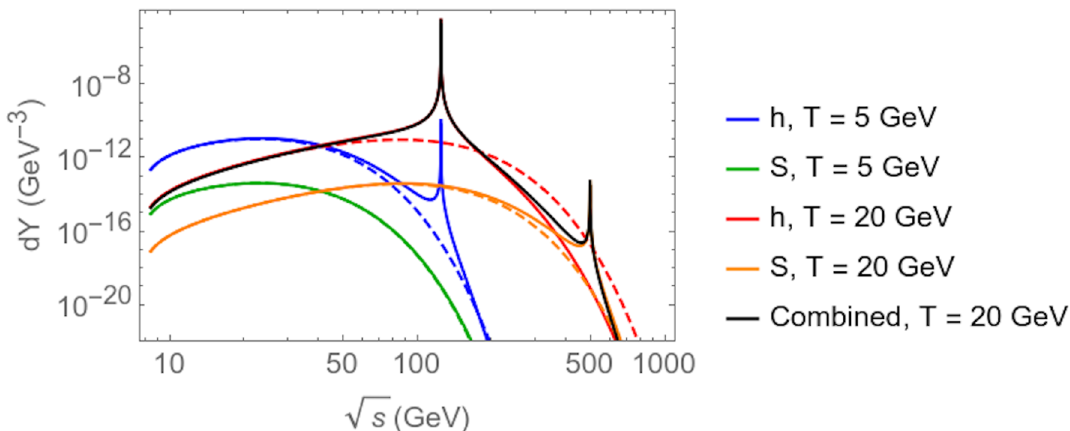
Figure 1 . Dark matter differential yield d 2 Y (in units of GeV − 3 ) from the annihilation process dTds √ ¯ bb → X ¯ X as a function of s , as obtained using the approximate EFT formula (dashed curves) and the full calculation (solid curves from integrand of eq. (2.11)) for two temperatures T = 5 GeV and T = 20 GeV. We show the SM Higgs ( h ) and heavy scalar ( S ) mediated contributions separately to highlight their relative sizes (the interference term is not shown); the total contribution (including interference) is shown with a black curve. For this plot, we use m S = 500 GeV, m X = 2 GeV, y hXX = 10 − 6 , and sin θ h = 0 . 1